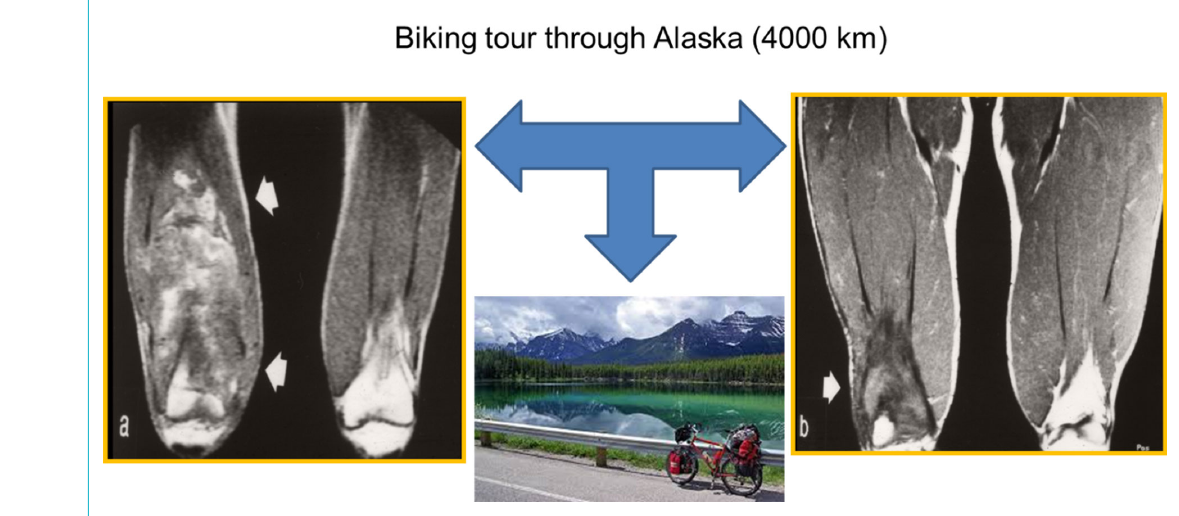
Figure 4: Example of spontaneous regression. An 18-year-old male athlete with a very large desmoid tumour located over the whole quadri- ceps muscles of the right thigh (a) with severe pain and the request for surgery with significant functional impact. Before surgery, he fulfilled a wish to ride his bike through Alaska, and the follow-up showed a significant decrease in the tumour size (b) and symptoms, removing the ne- cessity for